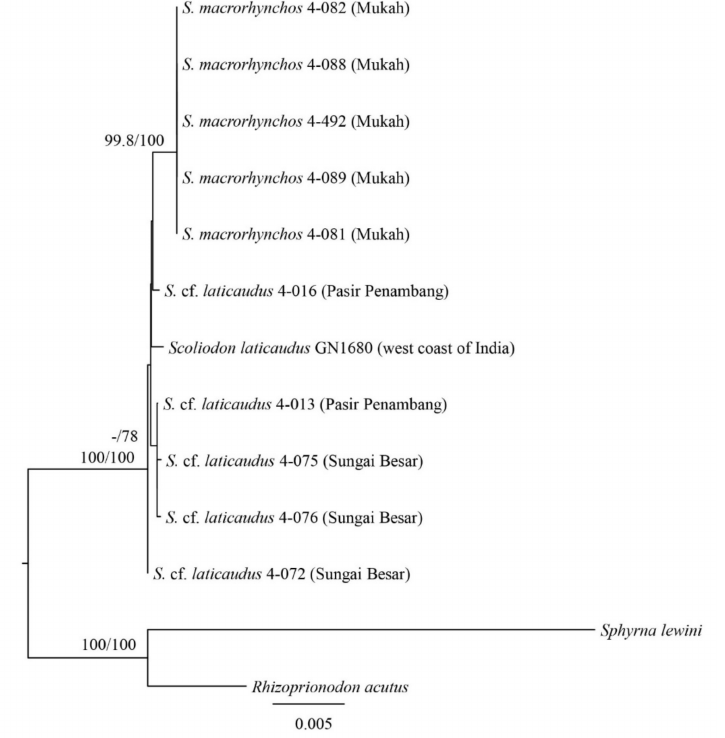
Figure 3. Nuclear gene mid-point rooting phylogenetic relationships of Scoliodon ‘species’ (phylo- gram). The bootstrap values (ML/BI) are shown at